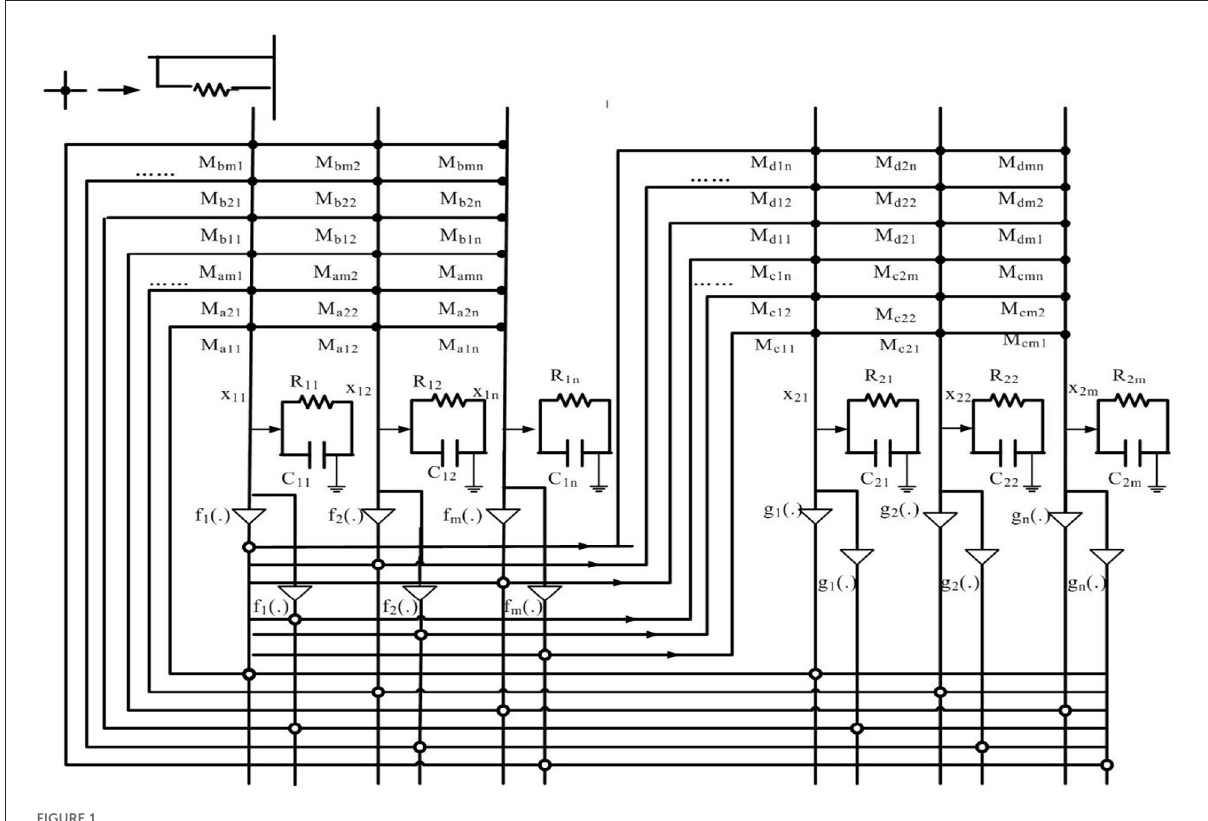
FIGURE1 Circuit of memristor-based